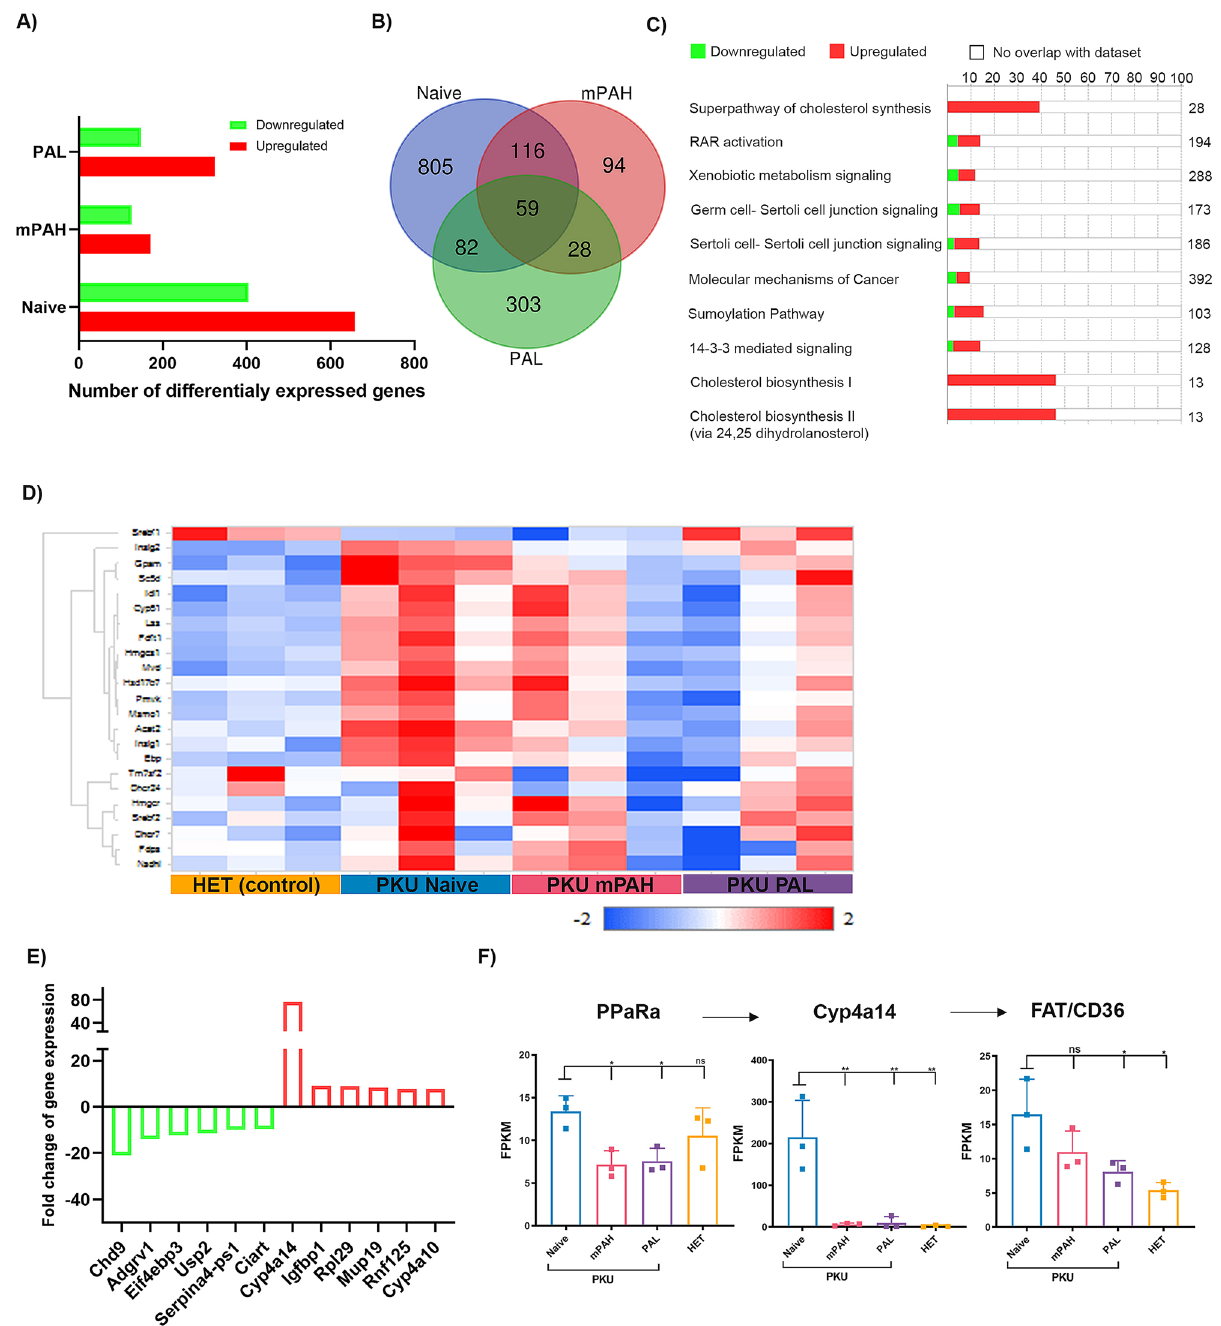
Figure 5. Gene expression changes in livers of PAH enu2 mice. (A) Number of differentially expressed genes in naïve, PAH and PAL treated PAH enu2 mice as compared to HET mice (HET). (B) Venn diagram showing number of DEG common and unique to each group. The majority of DEG in PAH enu2 mice are corrected after PAH or PAL treatment. (C ) Top 10 pathways affected in the liver of PAH enu2 mice as compared to HET mice analyzed by Ingenuity pathway analysis. Superpathway of cholesterol biosynthesis was the most affected pathway in the liver of PAH enu2 mice. (D) Heatmap showing the expression of genes involved in multistep cholesterol biosynthesis pathway. Most genes involved in cholesterol biosynthesis are upregulated in untreated PAH enu2 mice (PKU naive). The expression profile of PAH and PAL treated mice shares similarity to naïve HET mice (HET, control). Heatmap was generated using QIAGEN Omicsoft studio version 10.2.4.7. (E) Top 6 upregulated and downregulated genes in PAH enu2 mice as compared to naïve HET mice. (F) Modest increase in expression of PPARα, activator of Cyp4a14 and FAT, a downstream effector of high Cyp4a14 in PAH enu2 mice. Upregulation of Cyp4a14, PPARα and FAT is corrected in both PAH and PAL treated mice. N = 3 per group were used for analysis. One-way ANOVA Tukey’s multiple comparison, *p < 0.05 and **p <